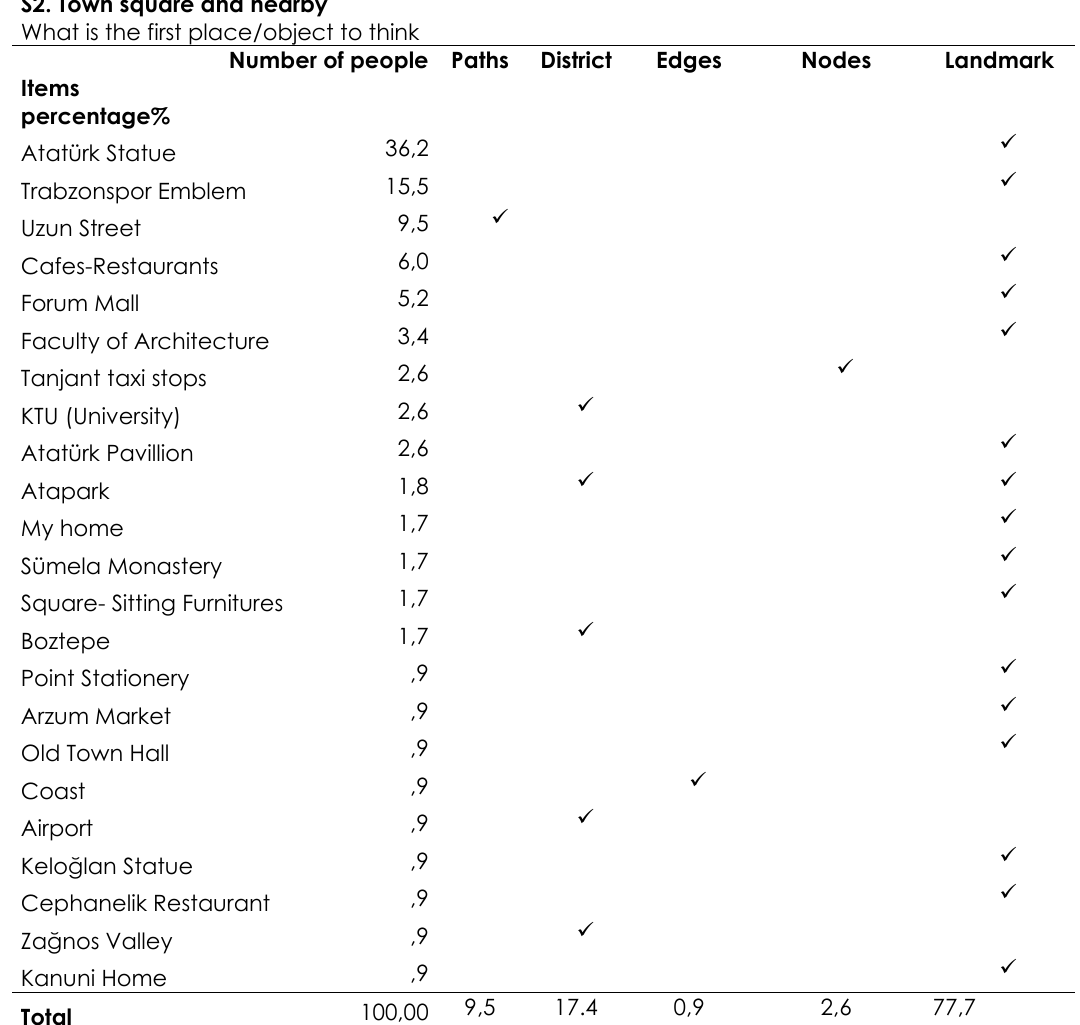
Table 4. Percentage (%) distribution of place/object preferences of the participants that first comes to mind on the city square and its close vicinity S2. Town square and